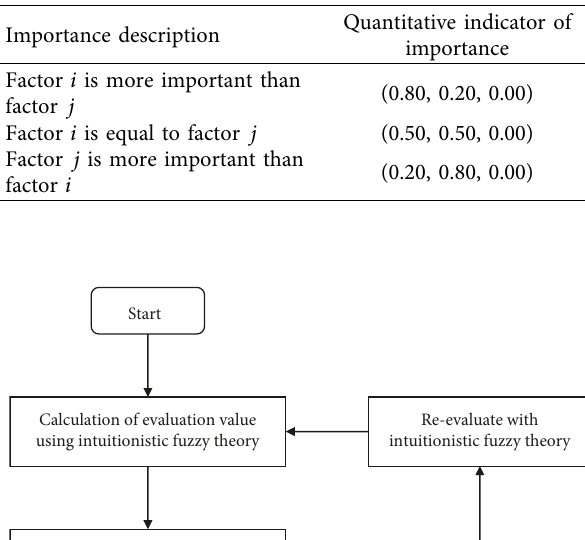
Table 5: Importance of